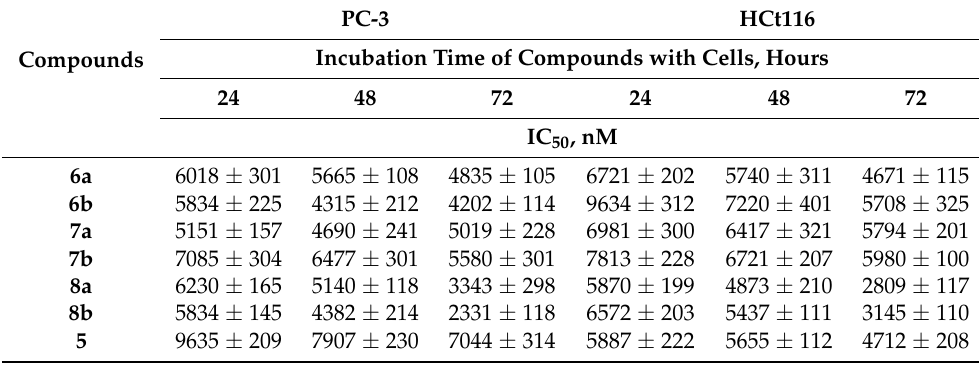
Table 2. Cytotoxic activity of compounds in